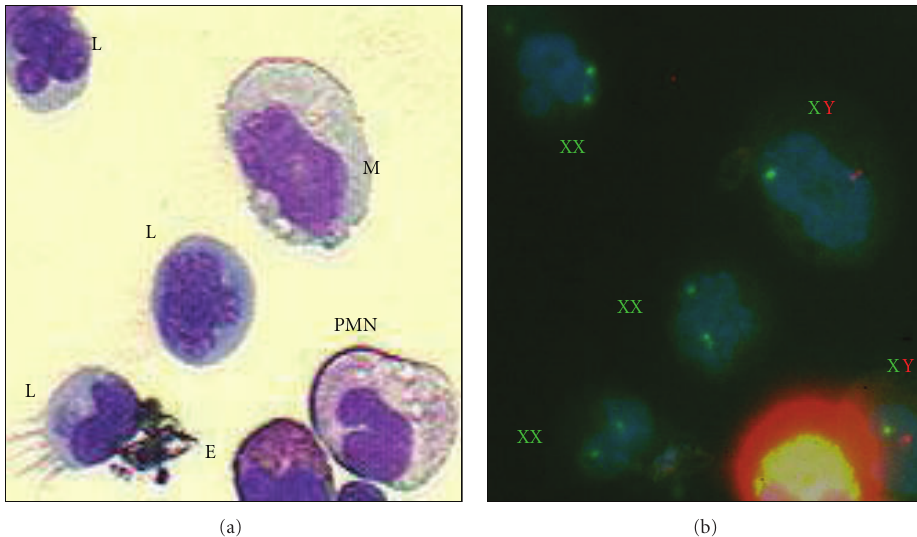
Figure 1: Visualization of the transplacentally acquired maternal cells. Combined morphological and FISH analysis confirmed the presence of transplacentally acquired maternal lymphocytes in patient 1 using the X and Y chromosomes probes. On the left (a), cells stained with Giemsa, and on the right (b) the same cells with FISH using dual-color XY DNA probe. XY genotype shows one green and one red FISH signals; XX genotype—two green signals. L = lymphocyte, YL = young lymphocyte, and PMN = polymorphonuclear cell.